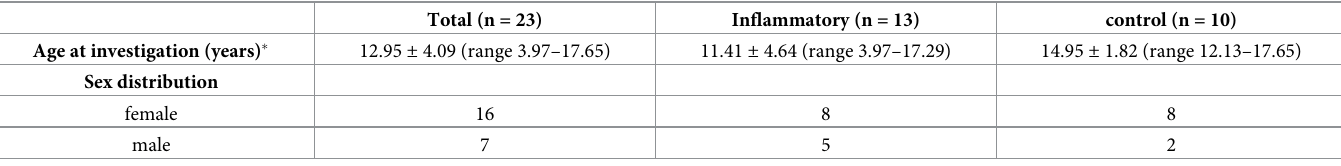
Table 3. Clinical data of samples for glycosylation studies.